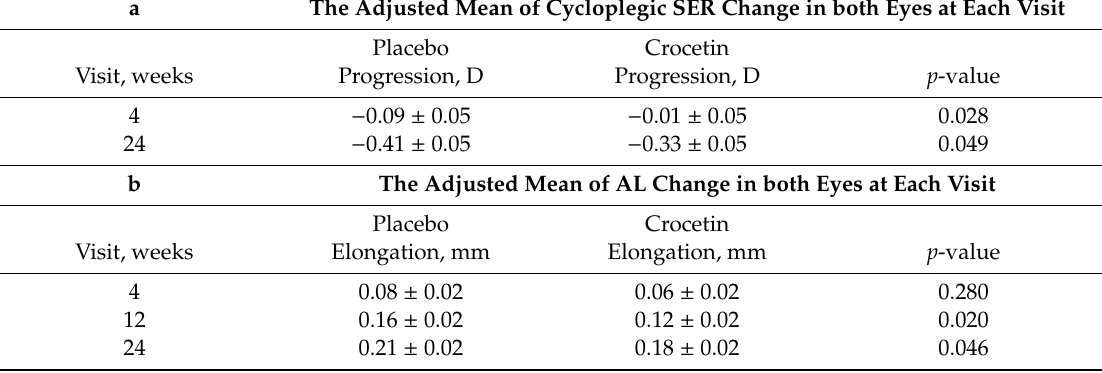
Time of sleeping (hours / day)